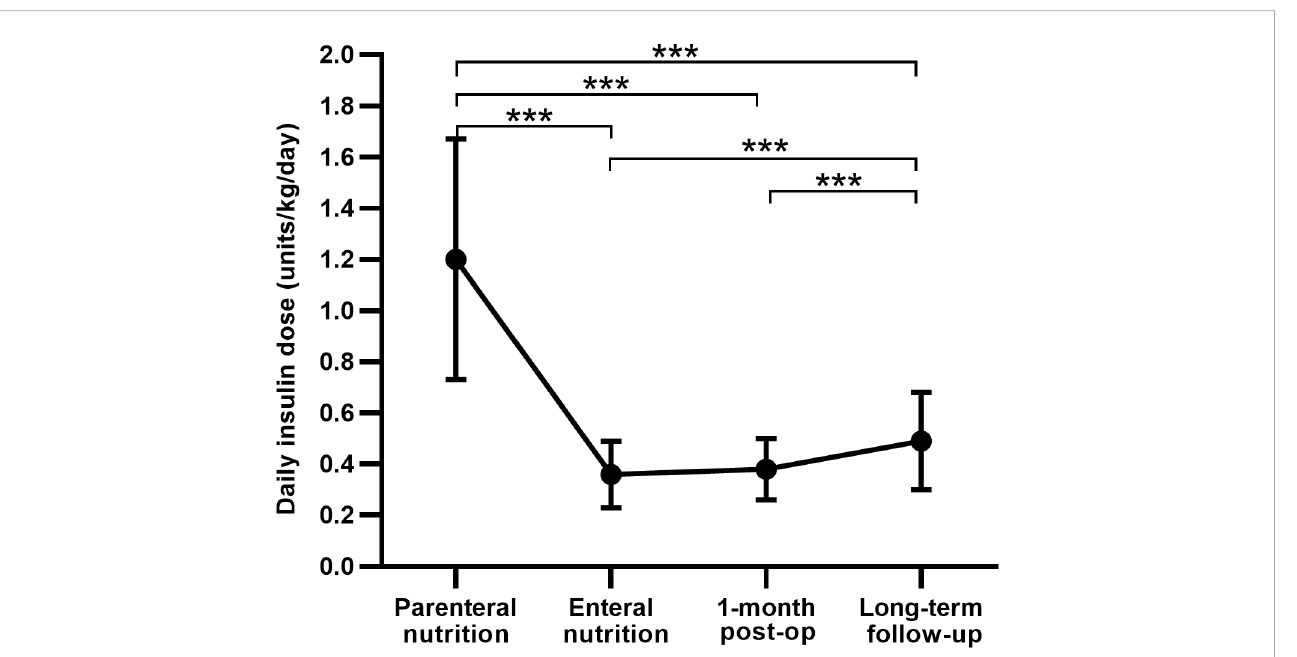
FIGURE 2 Comparison of the daily insulin dose between different periods after total pancreatectomy. post-op, postoperation. Data are presented as mean ± SD. *** P <